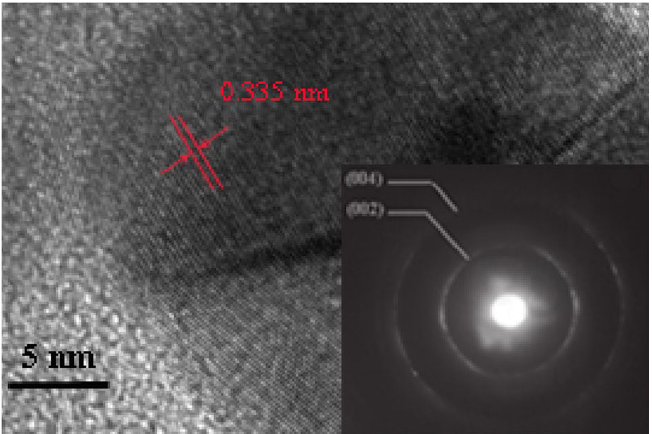
Figure 12. High-resolution transmission electron microscopy (HRTEM) measurement of a spherical carbon particle [58].